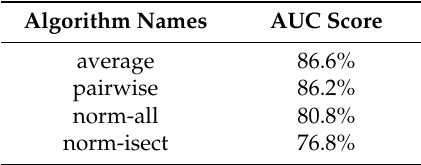
Table 3. Global reputation table of area under the ROC curve (AUC) score comparison on the biggest 100